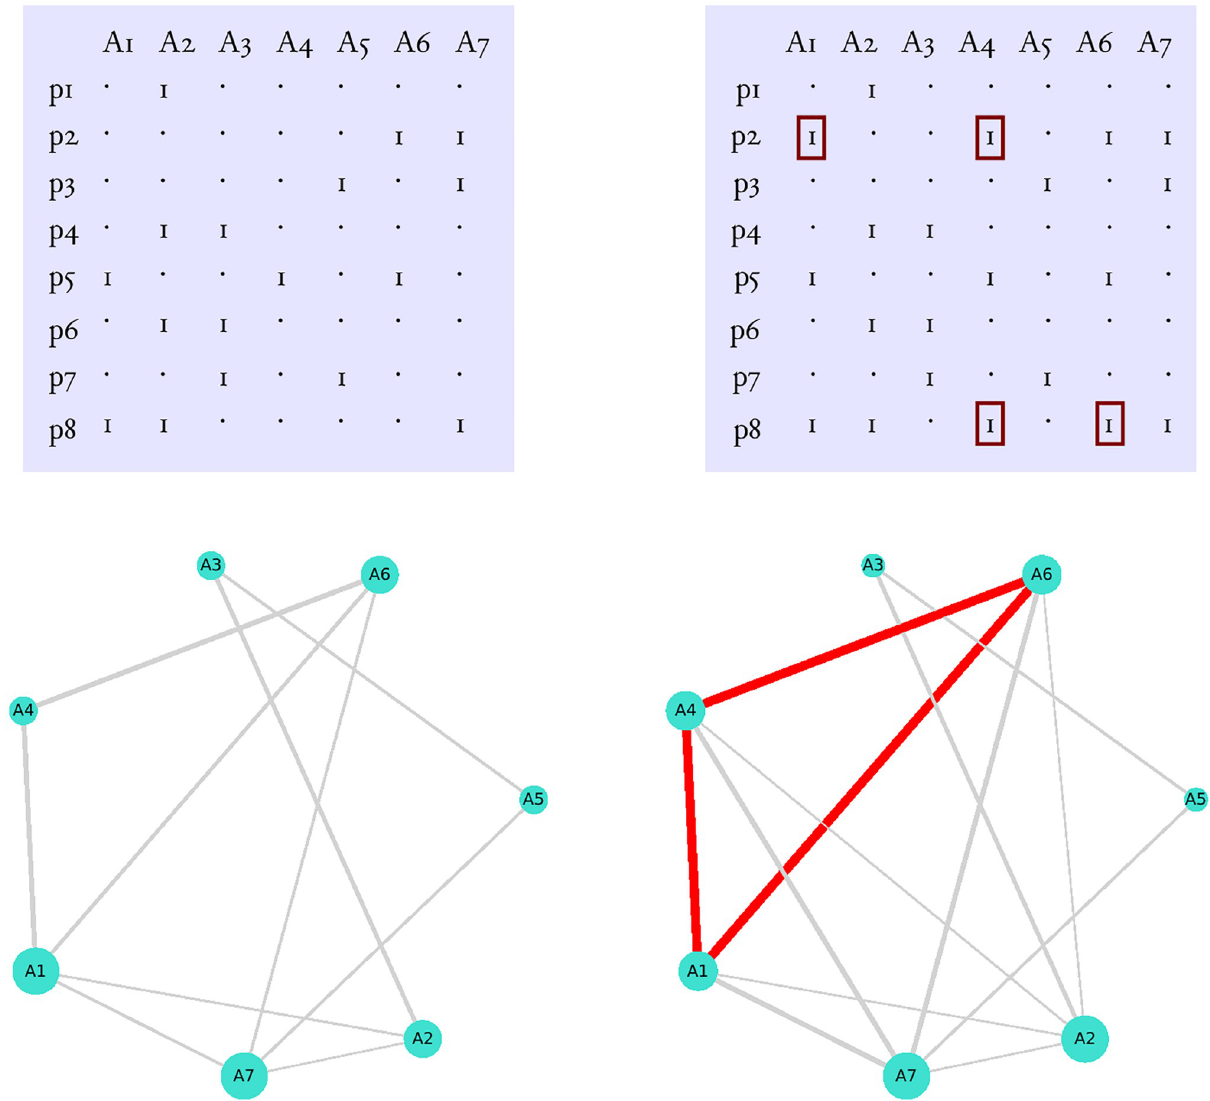
Fig 4. The formation of cartels. The panels on the left illustrate a publication network without cartel. The panels on the right show how a cartel between authors A1, A4 and A6 can be formed: Author A6 invites authors A1 and A4 to be coauthors on paper p2, while author A1 do the same with authors A4 and A6 on paper p8. The small red rectangles mark the authorships gained this way. The bottom right panel shows the resulting collaboration graph. Node size is proportional to the number of coauthors (degree), while edge width shows the strength of the connection between two authors (i.e. it is proportional to their Jaccard similarity). The red edges connect cartel members. Note (i) the strong connections between members and (ii) adding cartels also changes the connections of